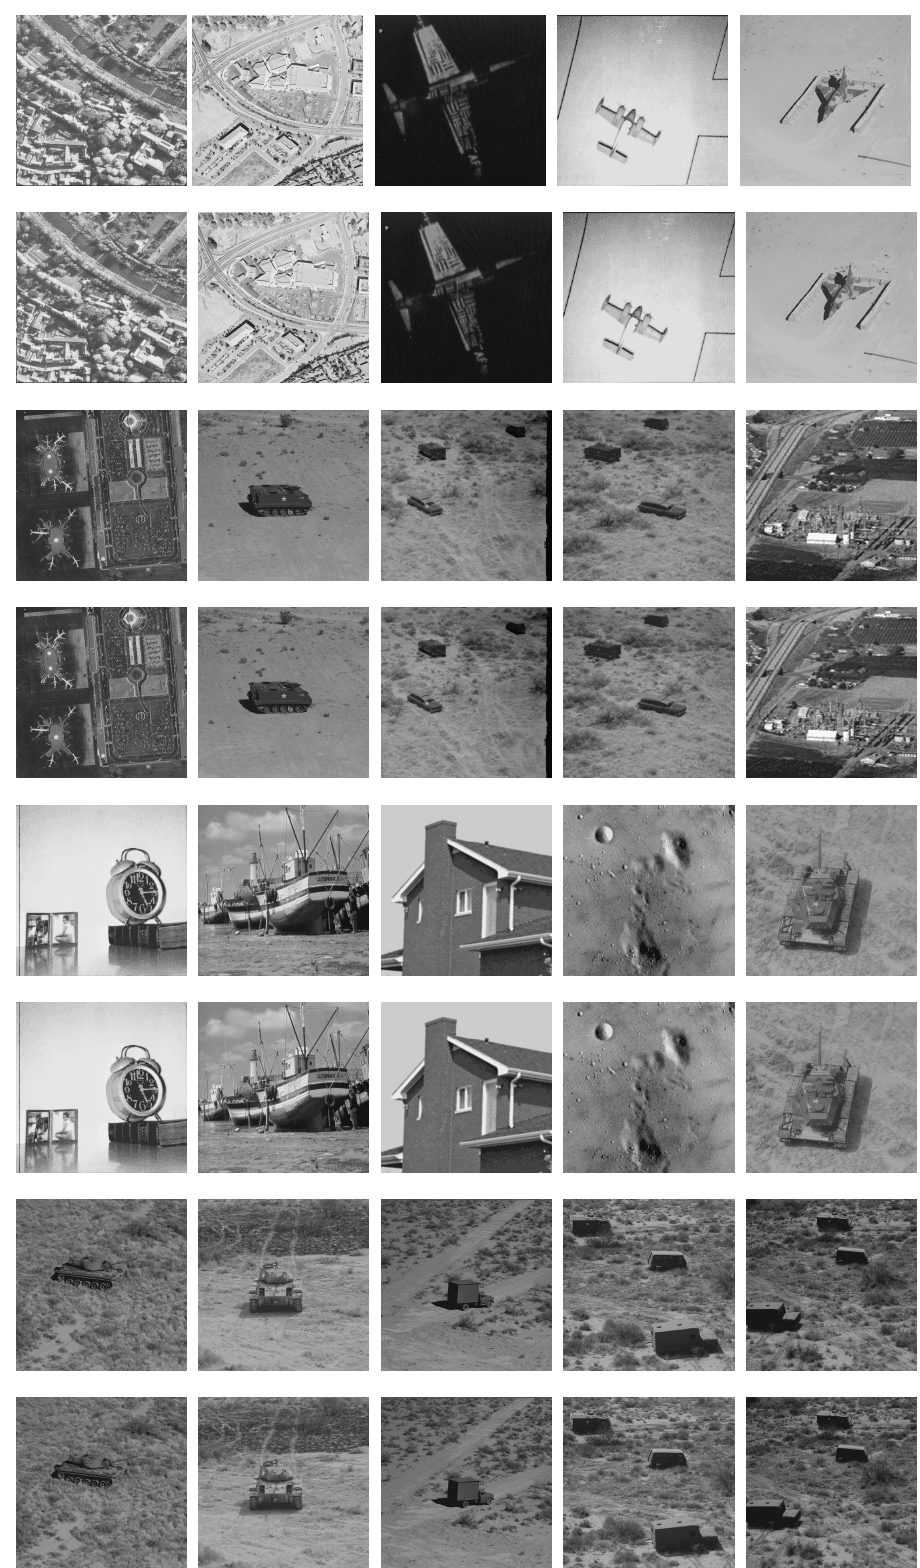
Figure A3. Twenty test images used in the experiments taken from [53] and their corresponding watermarked images. Odd lines represents the original images and the even lines refer to the corresponding watermarked